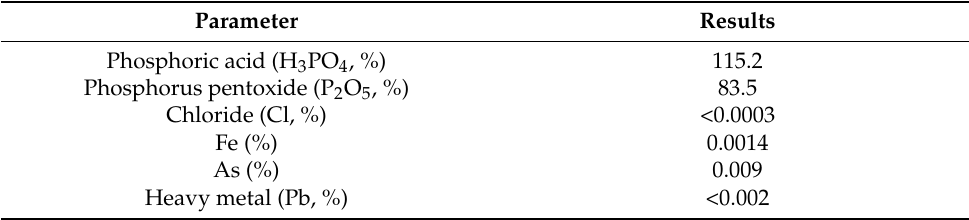
Table 3. Basic technical indexes of